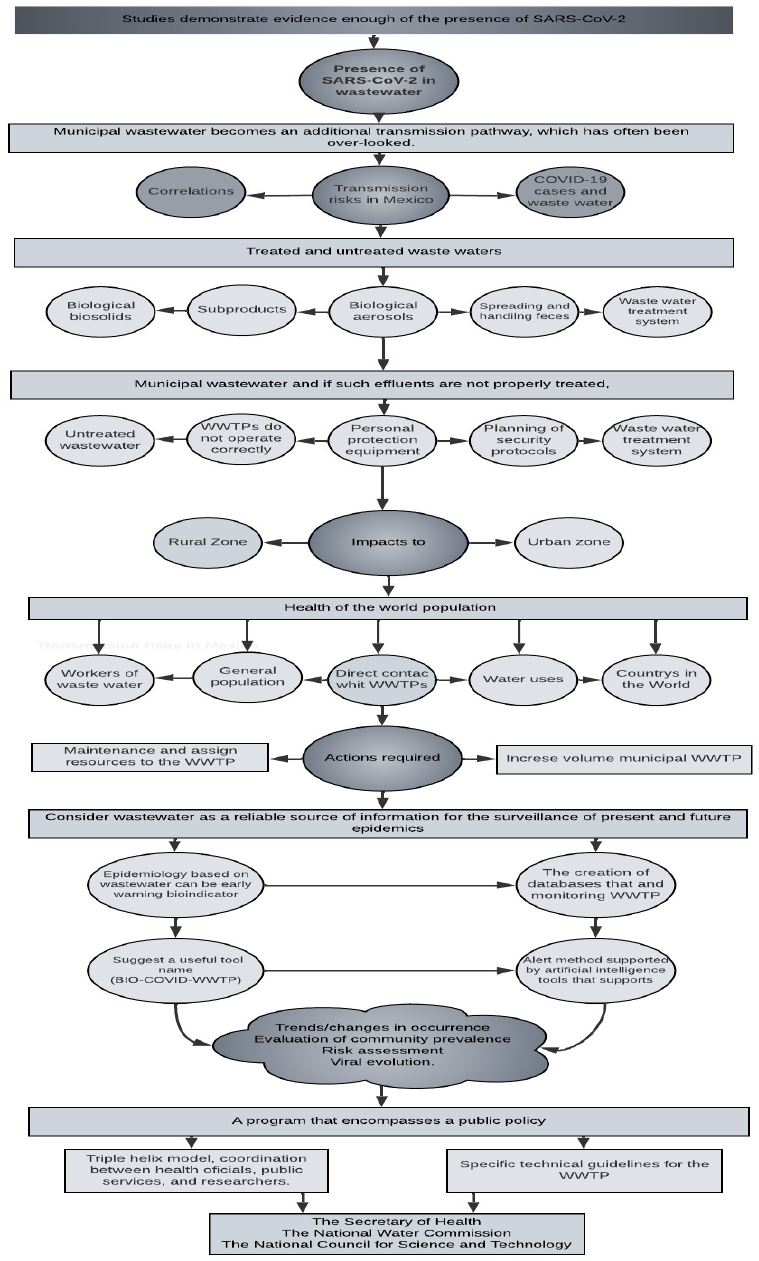
Figure 6. Diagram of relationships within the results of the investigation.